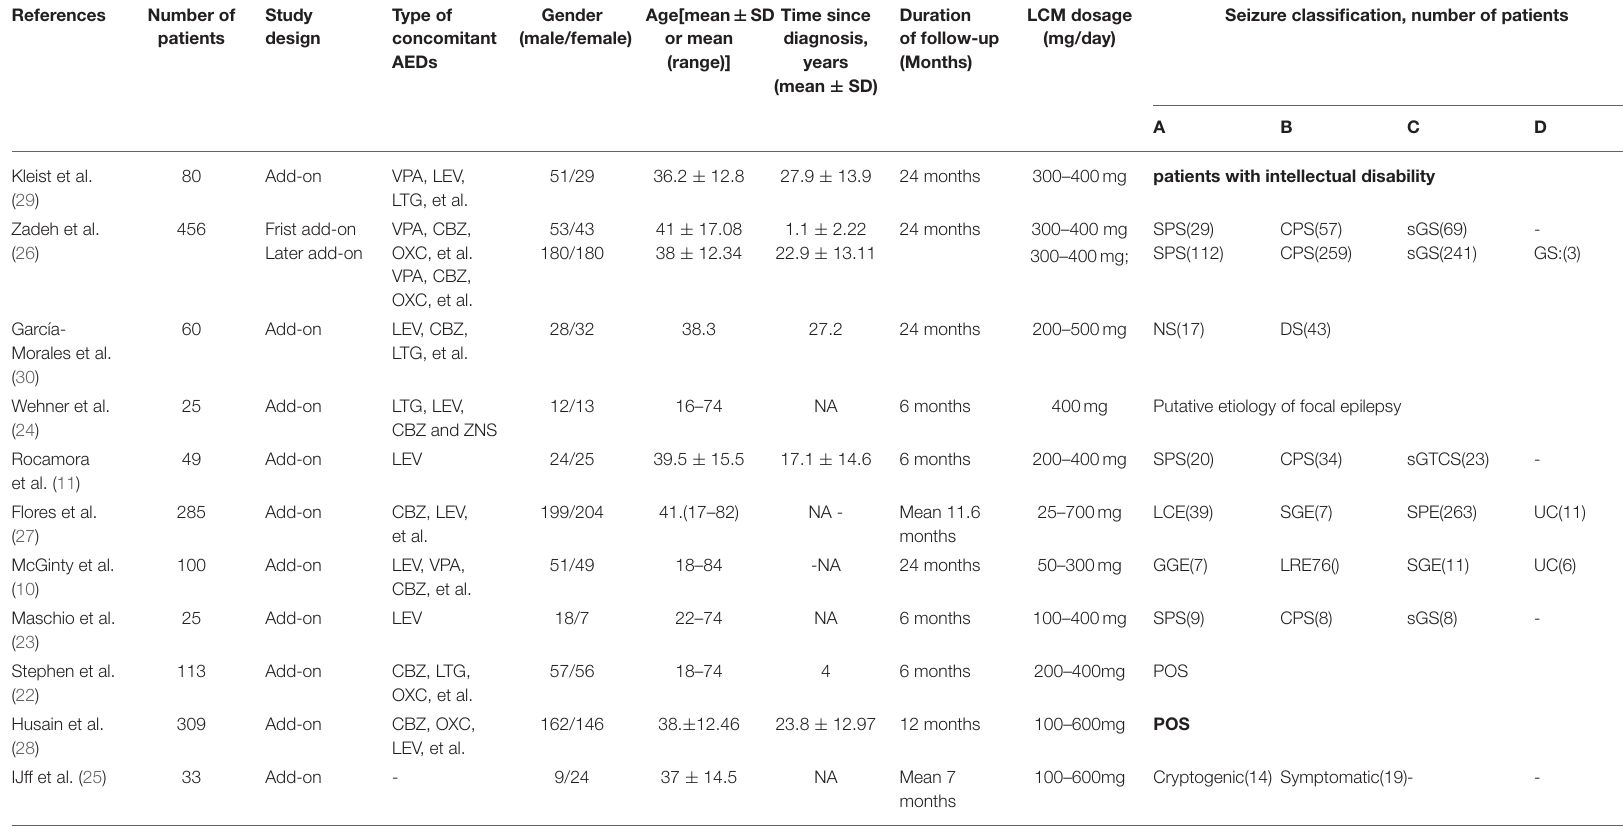
TABLE 2 | Characteristics of the observational studies included in this